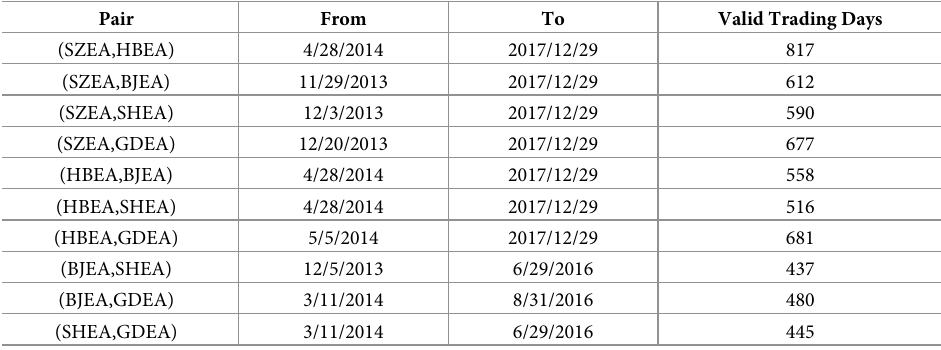
Beijing emission allowance is denoted by (BJEA), Guangzhou emission allowance by (GZEA), similarly, Hubei emission allowance by (HBEA), Shanghai emission allowance by (SHEA), Shenzhen emission allowance by